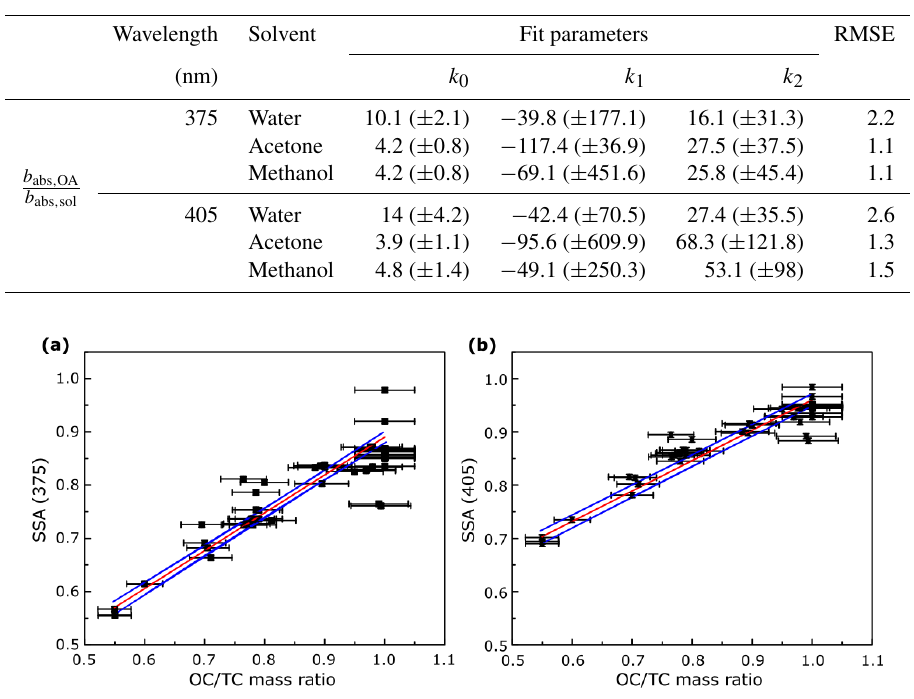
Figure 3. SSA at (a) 375nm and (b) 405nm as a function of the OC / TC ratio (sample size N = 49). The solid red lines are ODR fits to the data and the solid blue lines represent the 95% confidence intervals. The errors in OC / TC ratios were determined by the quadrature sum of uncertainties from EC / OC analysis and the errors in SSA were